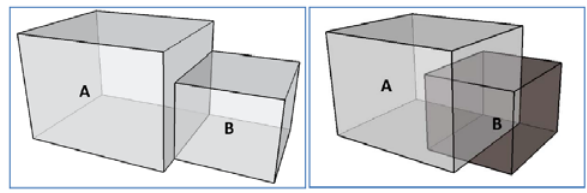
Figure 1. Correct topological relation (left) and incorrect topological relation (right) (after Zhao et al., 2012)